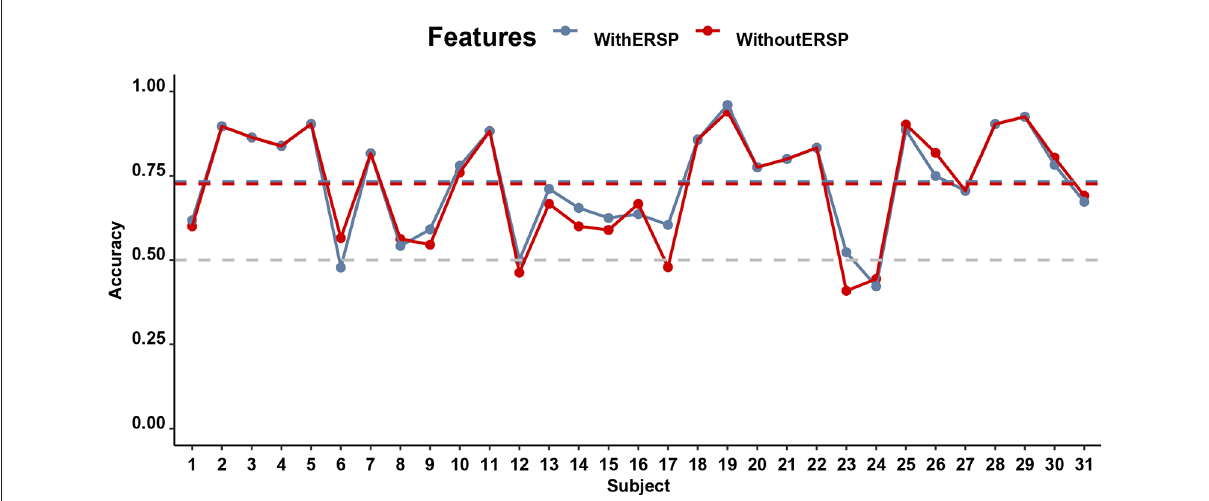
FIGURE6 Performance of the classifiers predicting stickiness on the basis of EEG for all participants. The gray horizontal dashed line indicates the chance level of 50% accuracy while the blue and red dashed lines indicate the accuracy of classifiers with and without the ITC, respectively.